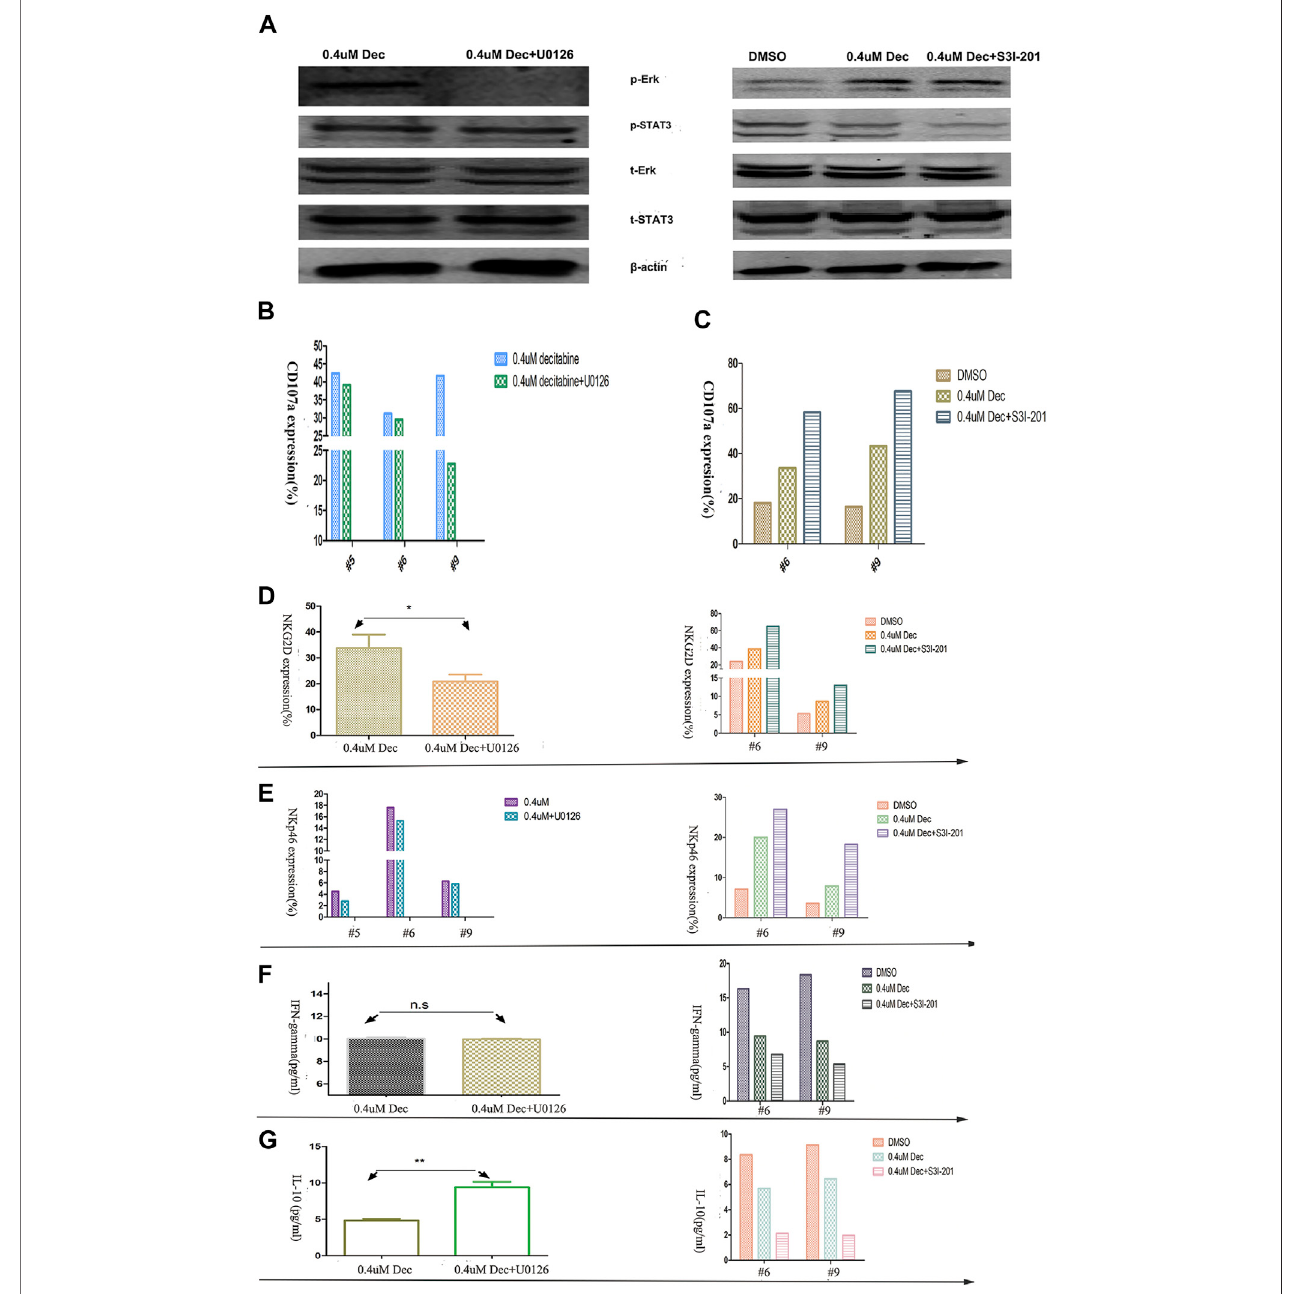
FIGURE 5 | Effects of ERK and STAT3 phosphorylation inhibitors on primary NK cells cytotoxicity, activating KIR expression, and cytokine release. (A) The responseofp-ERKandp-STAT3levelstoU0126(100 μ mol/L)andS3I-201(50 μ mol/L)exposure.InthecaseofU0126,NKcellswerepretreated,centrifuged,andthen exposed to decitabine (pretreatment omitted control group). In the case of S3I-201, NK cells were co- cultured with S3I-201 and decitabine (S3I-201 omitted control group) (B,C) U0126/S3I-201 (#5, #6, #9) effects on NK cells cytotoxicity, as indexed by CD107a expression (D,E) U0126 (100 μ mol/L) decreased and S3I-201 (50 μ mol/L)increasedtheexpressionofNKcell-activatingreceptors(NKG2DandNKp46)( n (cid:2) 3, p (cid:2) 0.027) (F,G) U0126versusS3I-201haddifferingeffectsoncytokine release ( n (cid:2) 3, p (cid:2) 0.0071).